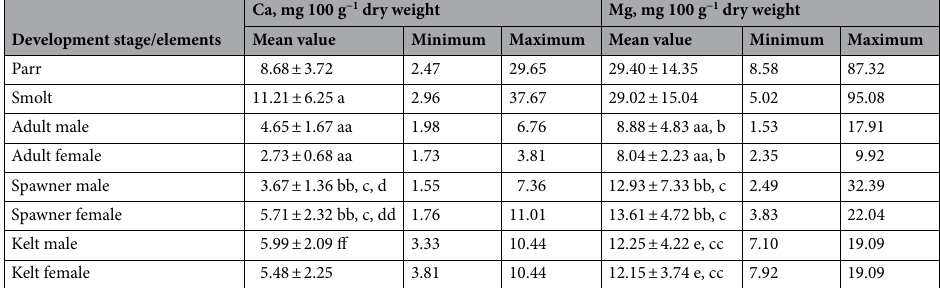
Table 3. Calcium and Magnesium levels (mg 100 g −1 dry weight) in the muscle tissue of the sea trout ( Salmo trutta m. trutta L. ) during different developmental stages. See as Table